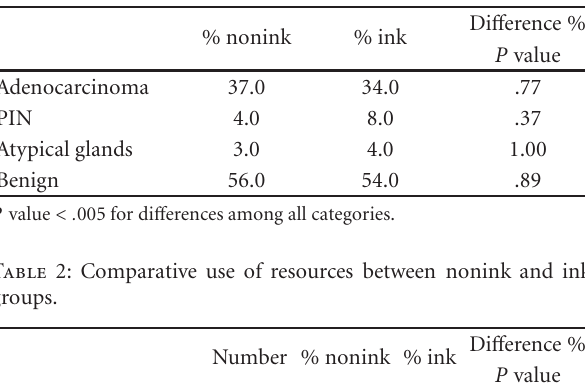
Table 1: Diagnostic proportion di ff erences between noninkand ing groups.